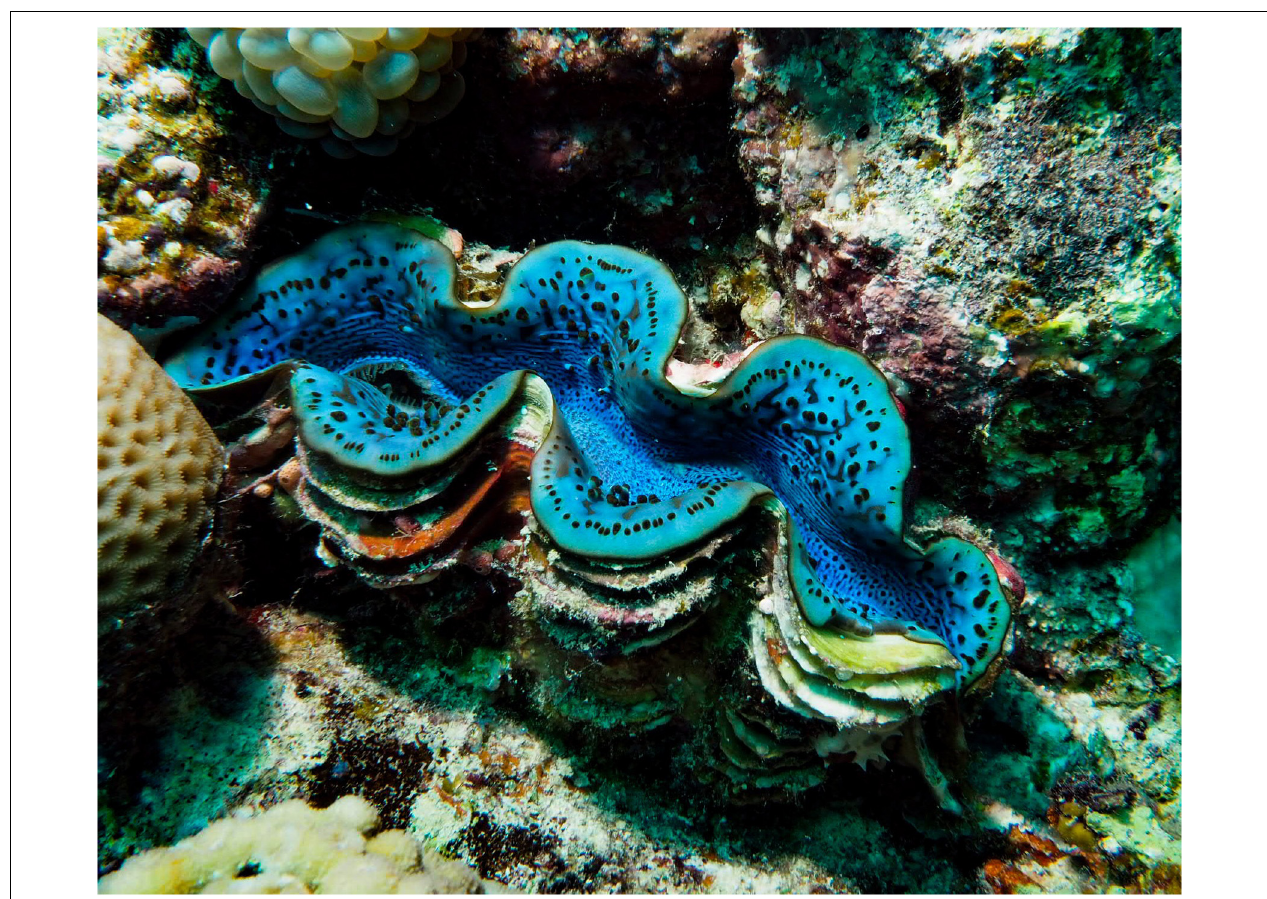
FIGURE 1 | Red Sea Tridacna maxima with its mantle